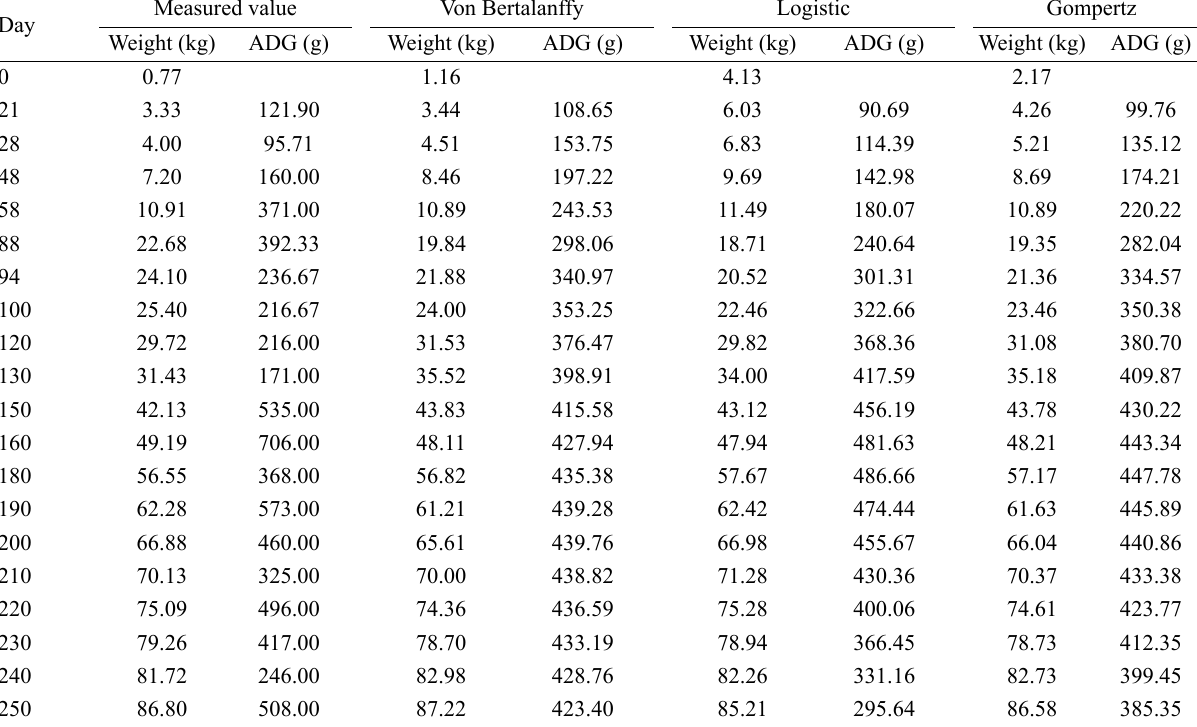
Table 3. The measured and estimated value of the body weight of Liangshan pig produced by different curve models Measured value Day